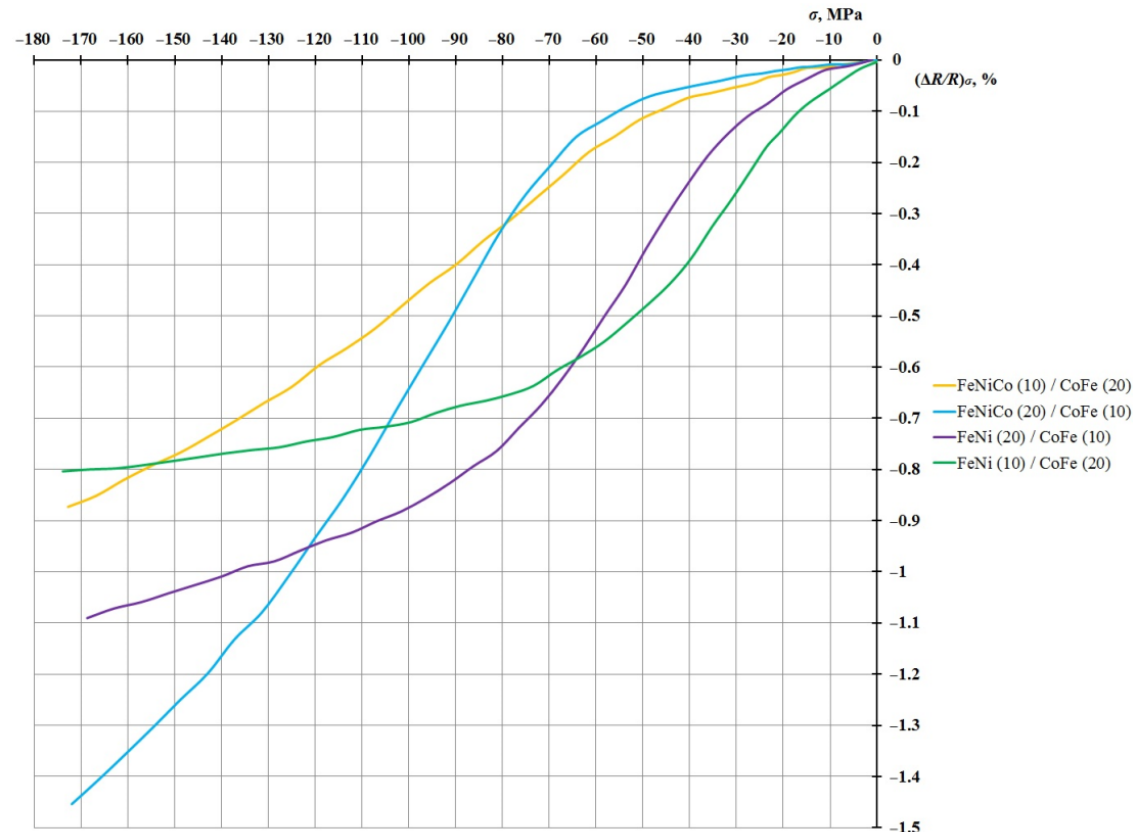
Figure 6. Dependence of the relative change in the resistance due to the load ( ∆ R/R ) σ on the value of mechanical stresses σ for the FeNiCo/CoFe and FeNi/CoFe nanostructures (layer thickness in nm). The sensitivity of magnetoresistive elements to mechanical deformation can be es- timated as GF = ( ∆ R/R) σ / ∆ ε , where ∆ ε is the deformation of the sensitive layer due to ∆ σ mechanical load within the elastic limits, ∆ ε = , where E f is Young’s modulus for the E f structure (110 GPa). The results of measuring relative change in resistance due to the load and the sensitivity coefficient for the seven studied nanostructures under mechanical compression deformation of 170 MPa are presented in Table 2. Table 2. Magnetoresistive characteristics of nanostructures (layer thickness in